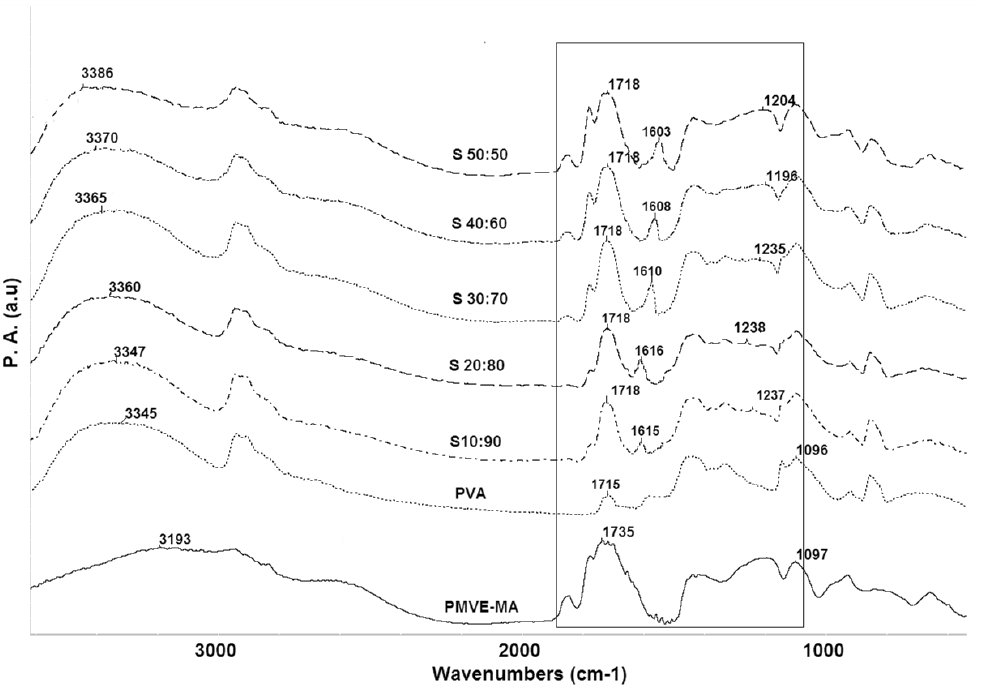
Figure 1. Fourier transform infrared spectroscopy (FTIR) spectra of poly vinyl alcohol (PVA), poly(methyl vinyl ether-alt-maleic anhydride) (PMVE-MA) and cross-linked PMVE-MA/PVA blends. The highlighted area represents the ester bonds formed during cross